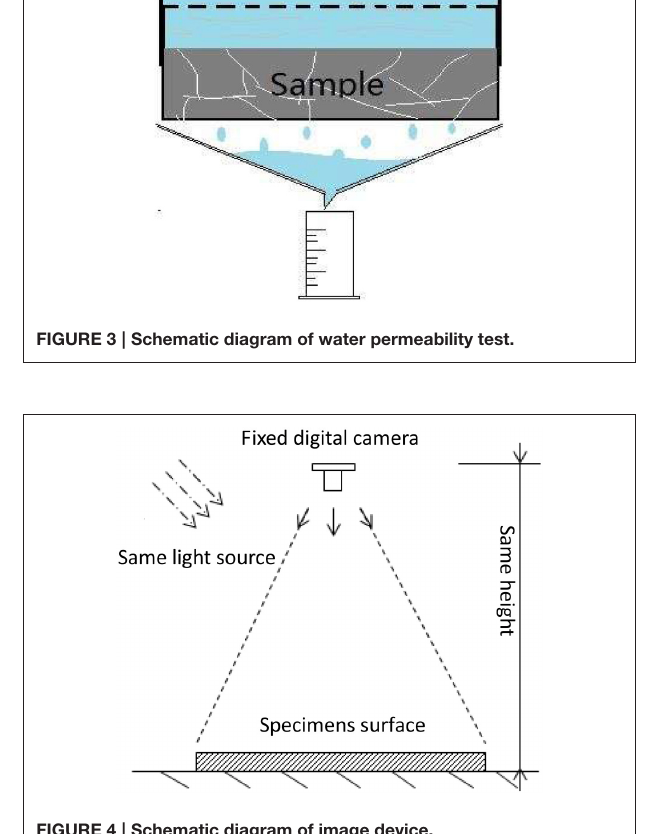
FIGURE 4 | Schematic diagram of image